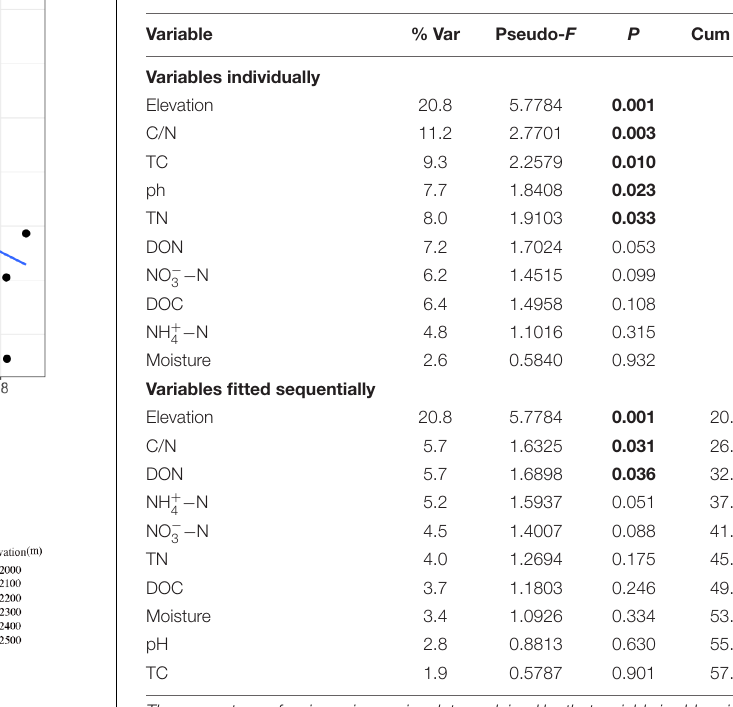
TABLE 2 | Distance-based multivariate linear model analysis (DistLM) for microbial fungal community